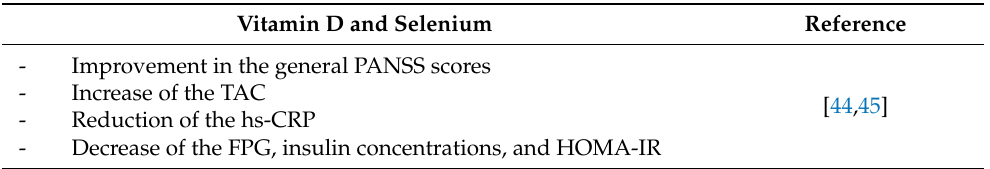
Table 2. Observed commune benefic role following 50,000IU vitamin/200 µ g/day selenium alongside LactoCare ® in SCZ